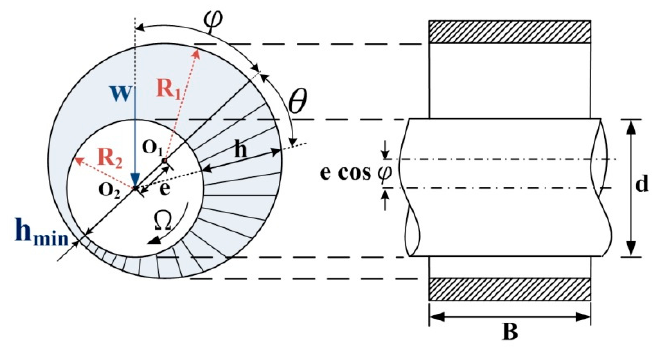
Figure 3. Schematic diagram of pressure distribution of hydrodynamic bearing.